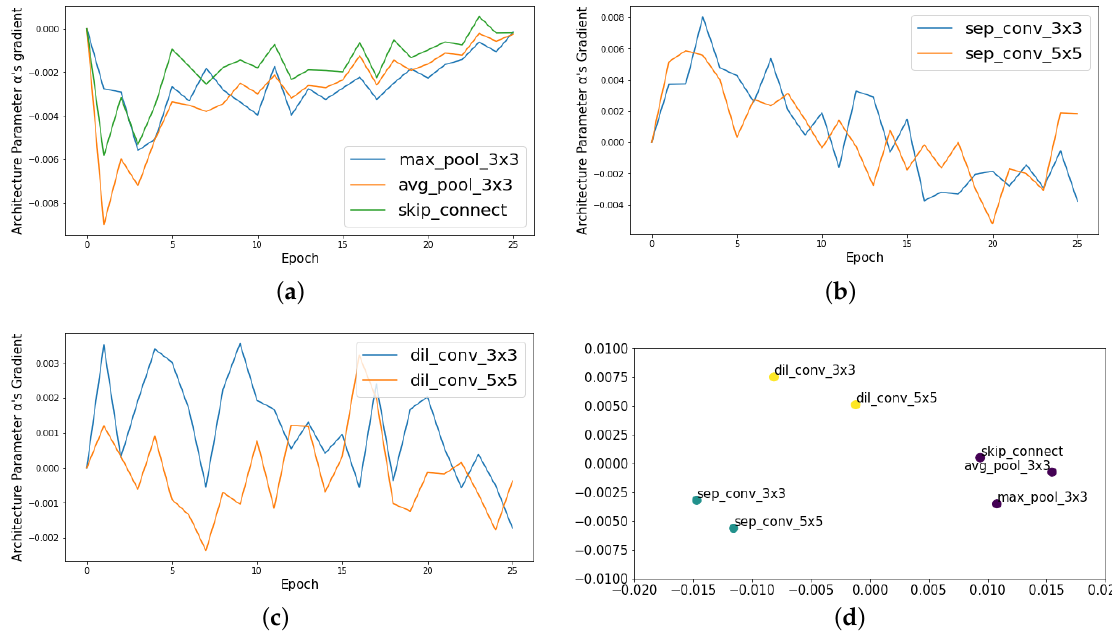
Figure 5. Gradient over stage 1 epoch progression: First mixed operation of a cell. ( a ) Cluster 1: First mixed operation’s gradient in a normal cell. ( b ) Cluster 2: First mixed operation’s gradient in a normal cell. ( c ) Cluster 3: First mixed operation’s gradient in a normal cell. ( d ) PCA by first mixed operation’s gradient in a normal